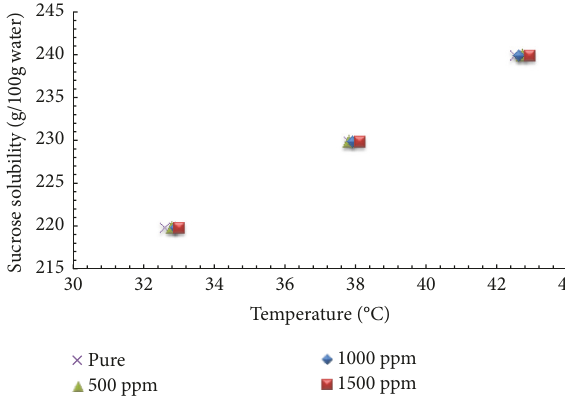
Figure 2: Sucrose solubility in water for different concentrations of